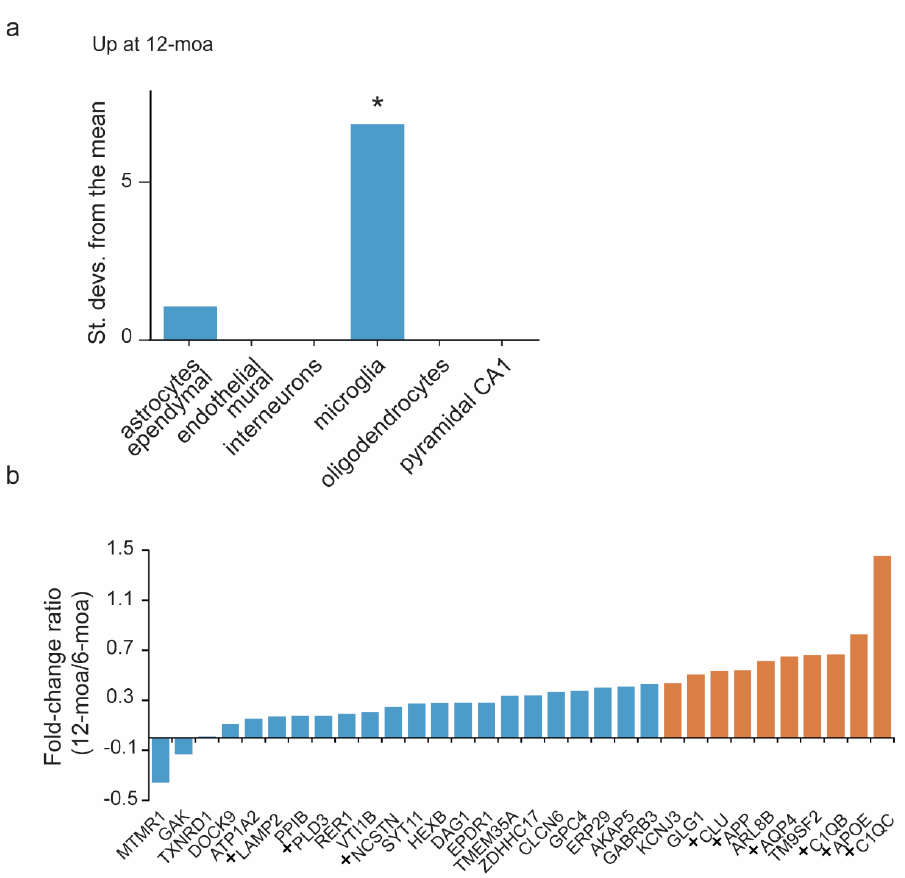
Figure 5. Cell-type enrichment and analysis of changing levels of protein expression over time. ( a ) Expression Weighted Cell-type Enrichment performed using single cell RNAseq level 1 cell-type data obtained from [27], on the upregulated proteins at 12-moa. * p -value < 0.01. ( b ) Fold-change ratios are shown for all proteins regulated in at least one of the two datasets demonstrating their level of regulation over time. Proteins labeled with a + have been implicated in human AD in earlier reports, see Table S1. The top 10 most regulated proteins over time are highlighted in orange.